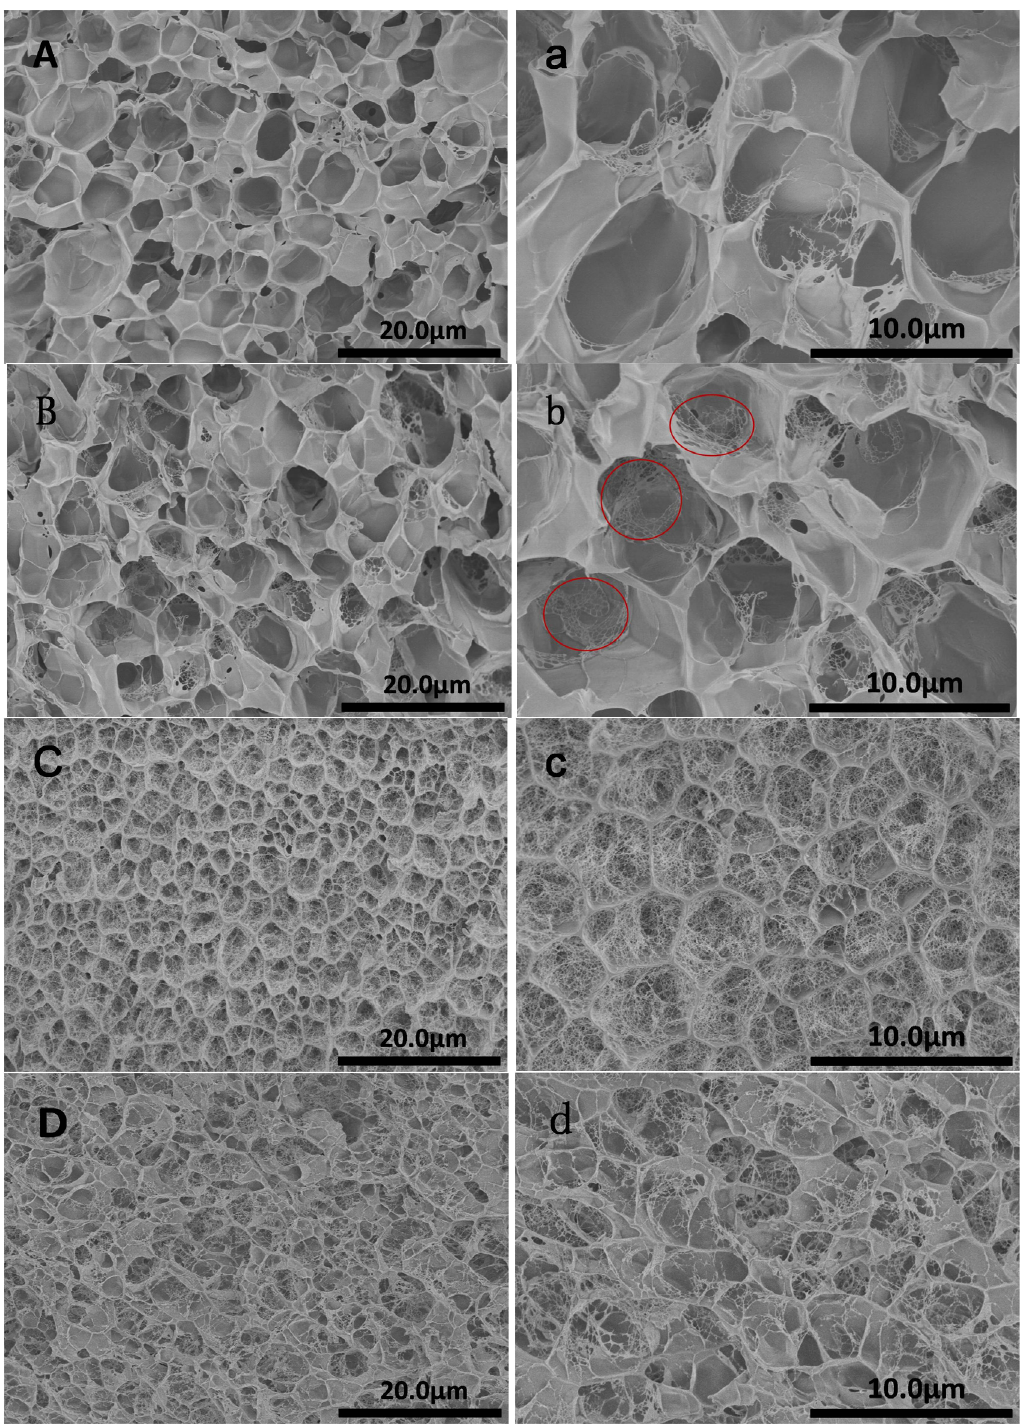
Figure 5. SEM images of nanocomposite DN hydrogels ( A , a ) CNTs-0; ( B , b ) CNTs-0.5; ( C , c ) CNTs-1 and ( D , d ) CNTs-4. The embedded micro-network structures were shown in the red